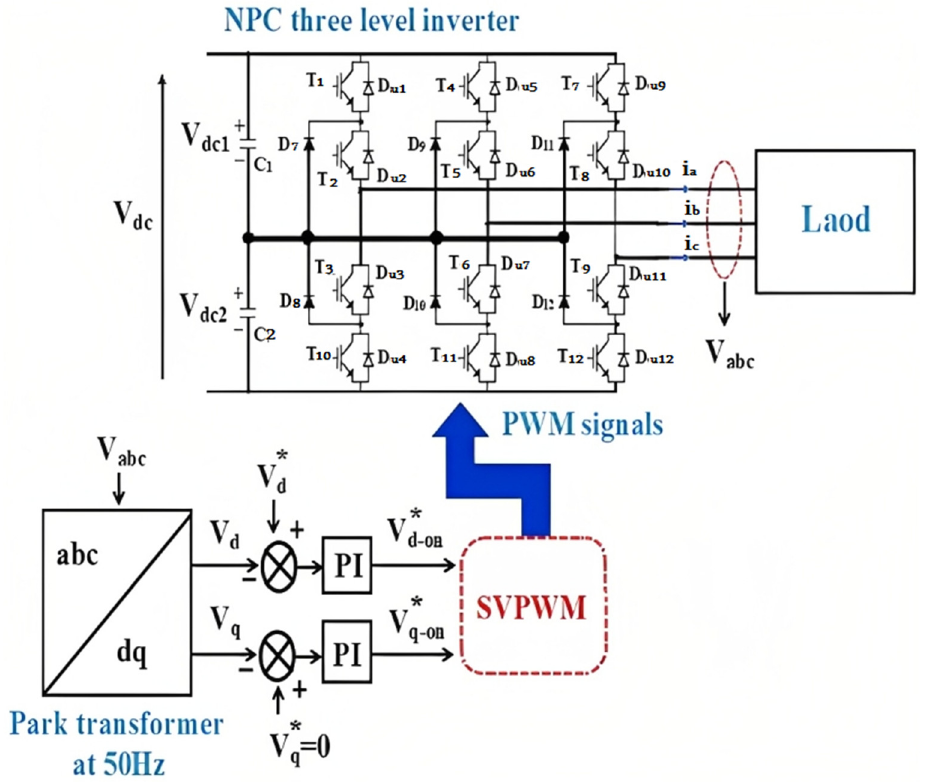
Figure 5. Load voltage control using three-level NPC inverter and SVPWM, where “*” indicate the references of the V d and V q